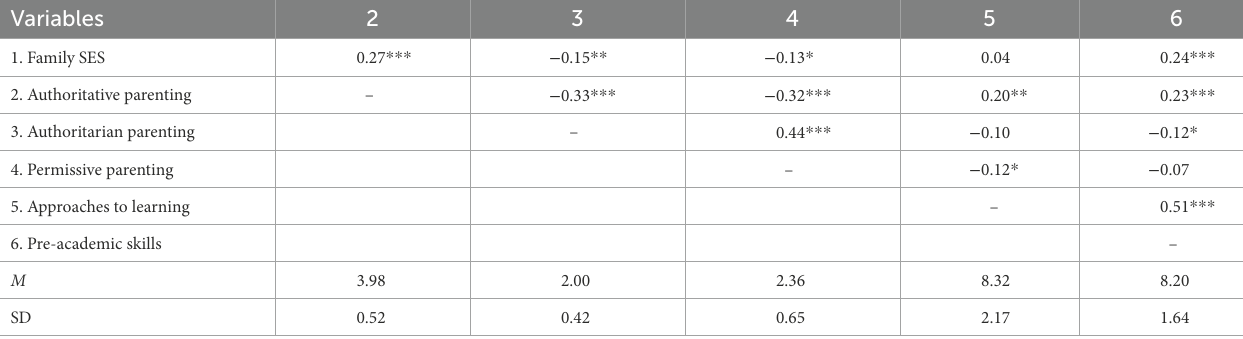
TABLE 1 Means, standard deviations, and zero-order correlations of main variables.